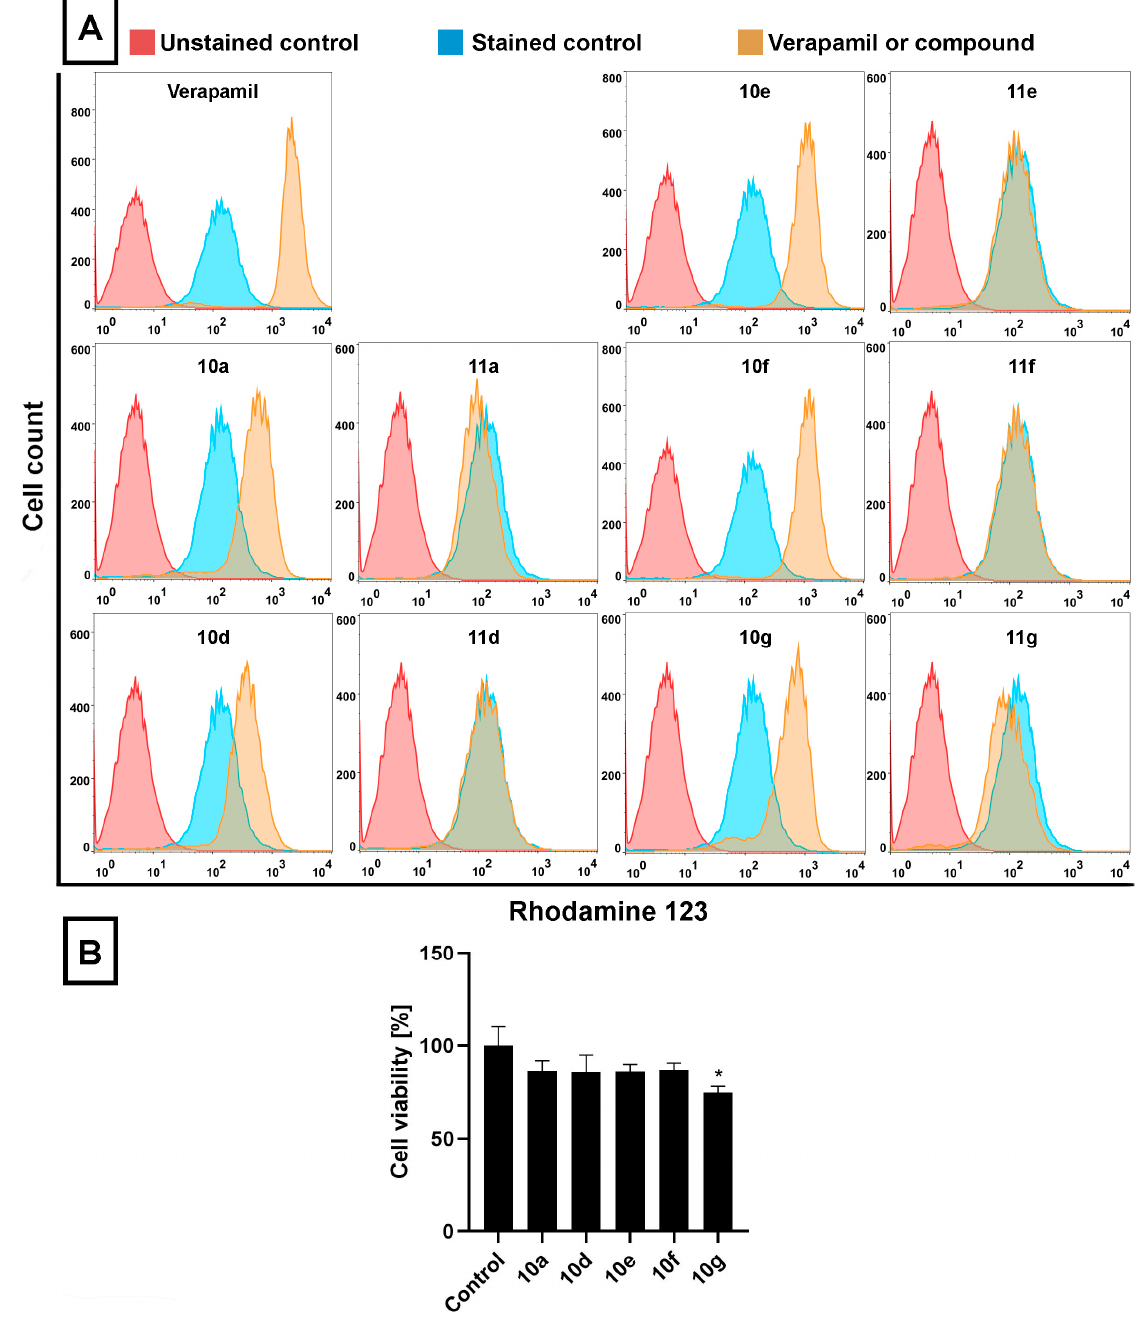
Figure 2. Acetylated androstano-arylpyrimidines attenuate the efflux transporter activity in multidrug-resistant Colo 320 cells. ( A ) Retention of Rhodamine 123 in Colo 320 cells treated with acetylated ( 10a, 10d, 10e, 10f, or 10g ) and deacetylated ( 11a, 11d, 11e, 11f, or 11g ) androstano-arylpyrimidines (at 20 µ M concentration for 24 h) or with Verapamil (40 µ M, 2 h treatment). Rhodamine 123 fluorescence of at least 10,000 cells/sample was measured by flow cytometry. ( B ) The viability of Colo 320 multidrug-resistant colon cancer cells treated with acetylated androstane compounds 10a, 10d, 10e, 10f, or 10g (at 20 μ M, for 24 h, 10 4 cells/well density) was assessed by MTT cell viability assay. Bar graphs represent mean ± SD values. Fisher’s LSD test, *: p < 0.05.